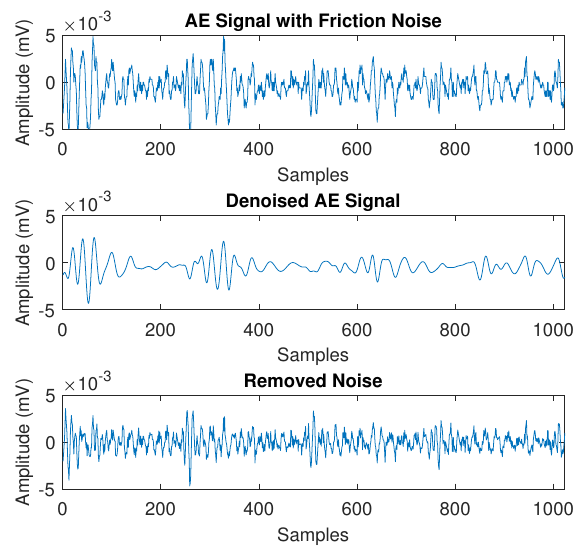
Figure 5. Comparison among frictional noisy AE signal generated from hydrogen evolution experiment, the signal after denoising and estimated